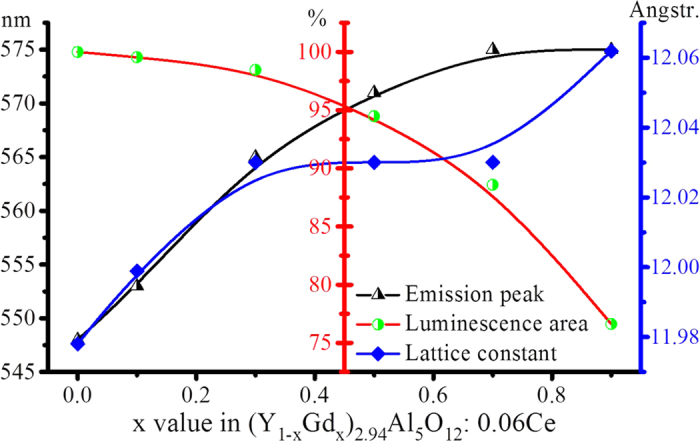
The relationship of emission peak, integrated intensity of luminescence and crystal lattice constant of (Y1−xGdx)3Al5O12: Ce as a function of the x value.